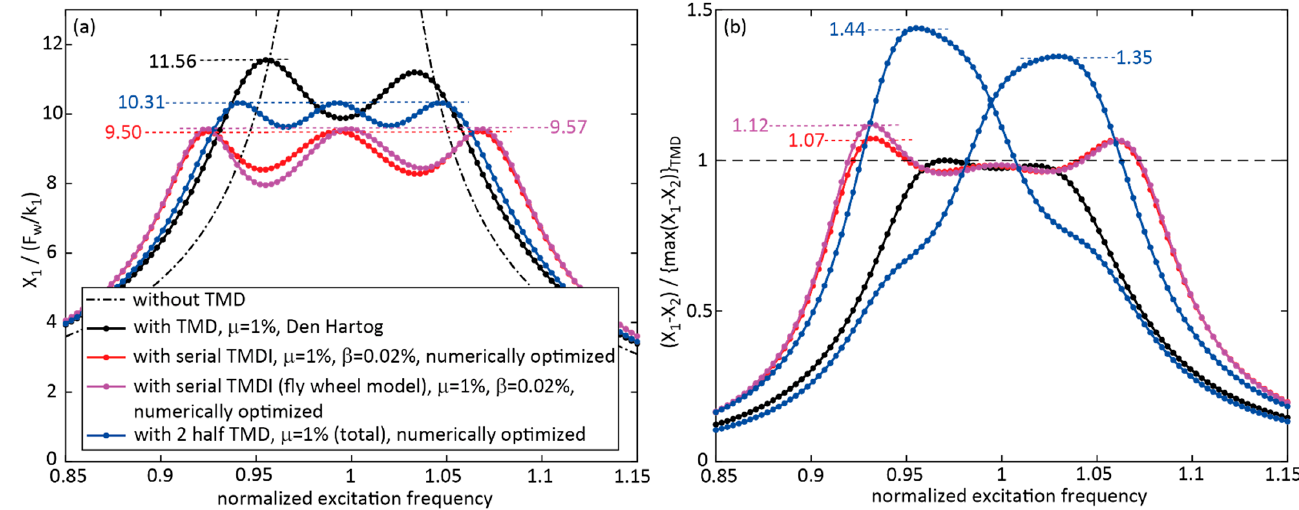
Figure 11. Performances of TMDI with serial arrangement of stiffness, inerter and damper ( µ = 1%, β = 0.02%, numerically optimized parameters), TMD ( µ = 1%, Den Hartog parameters) and two half TMDs ( µ = 1%, numerically optimized parameters) for harmonic excitation: ( a ) primary structure normalized displacement response and ( b ) normalized damper relative motion response.